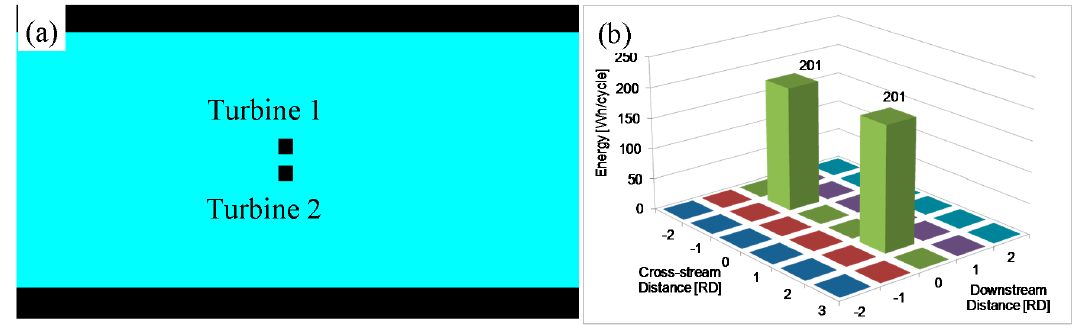
Figure 9. ( a ) Turbines in 2 RD simulation and ( b ) energy captured by each turbine.